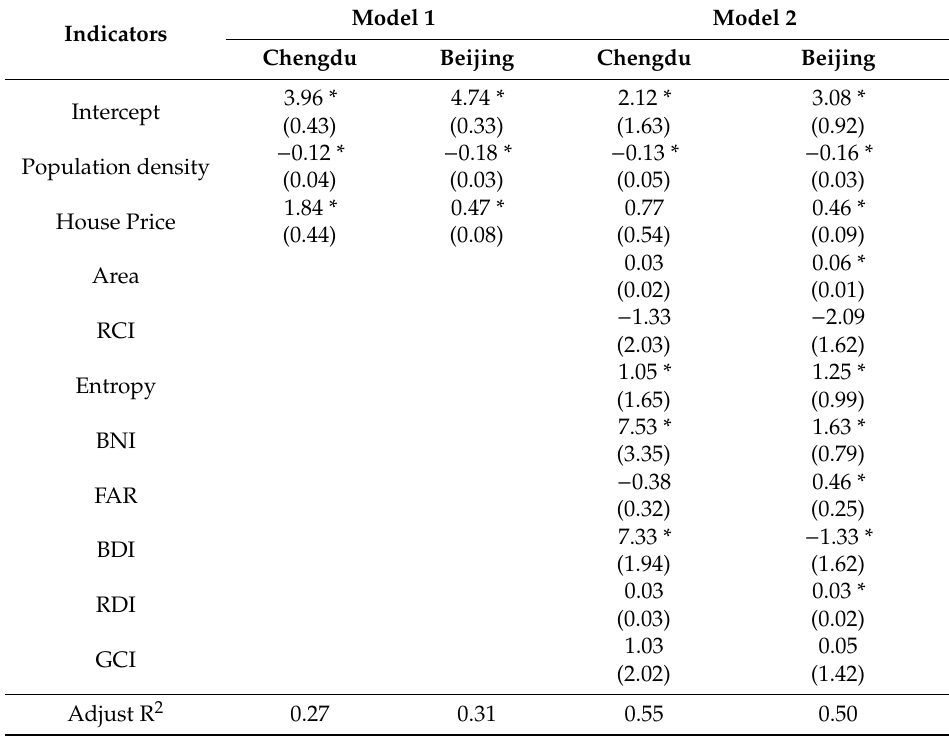
Table 2. Regression results for the impact of built environment on neighborhood vibrancy. Model 1 Model 2 Indicators